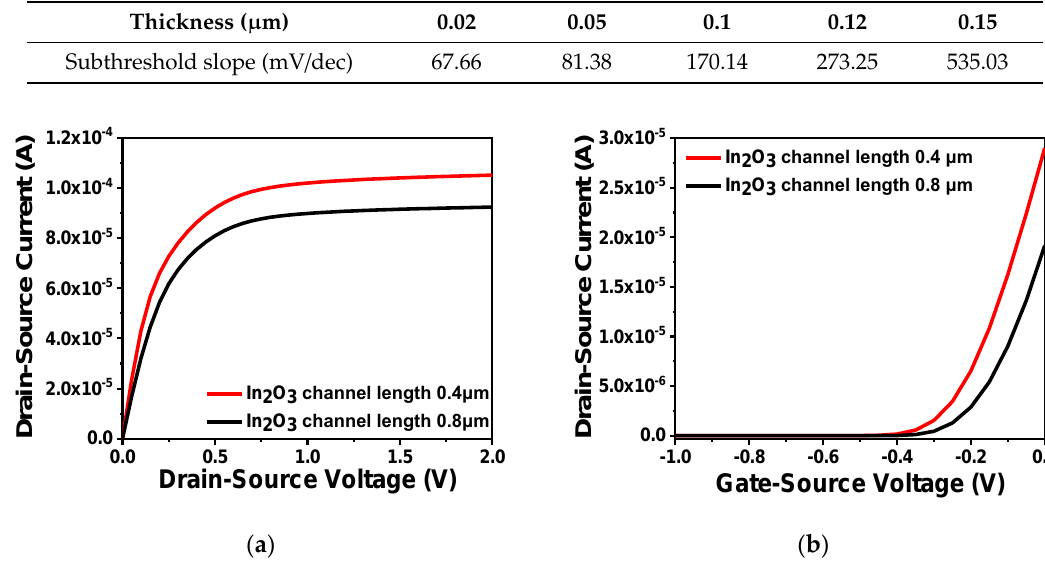
Figure 5. Characteristics of different channel thickness: ( a ) output characteristic curve of different channel thickness; ( b ) transfer characteristic curve of different channel thickness.